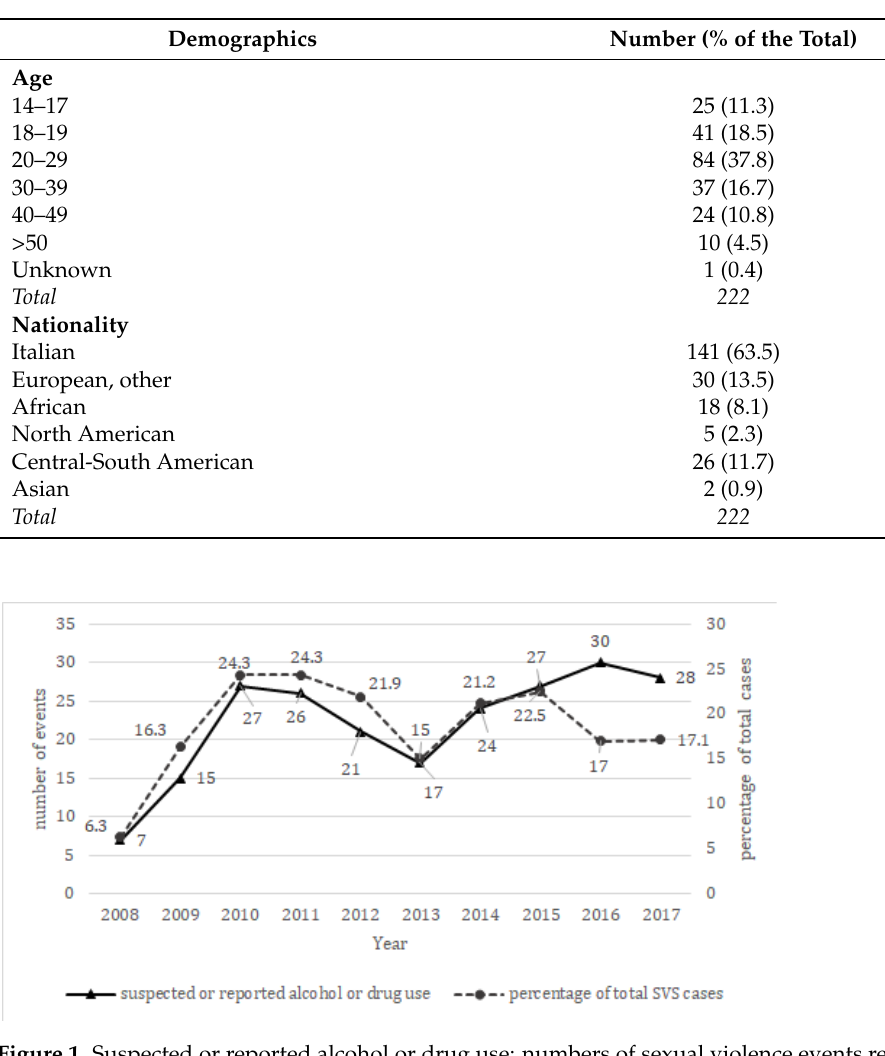
Table 1. Demographics of the population enrolled.